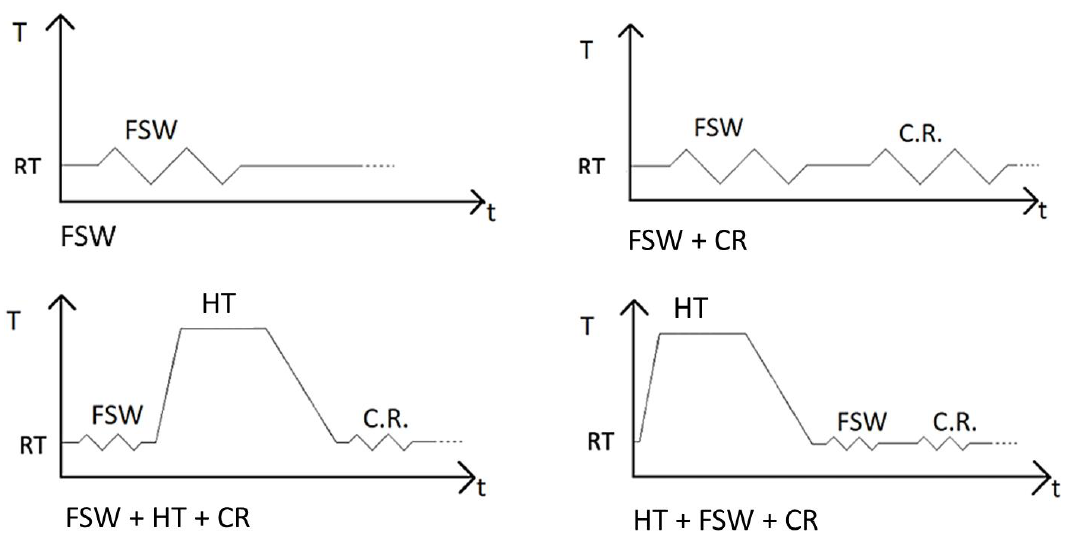
Figure 1. Schematics of the combinations of thermo-mechanical processes used in the present paper. Butt joints were obtained by FSW experiments carried out using the COMEC TM M50 (DRIVER M50 2T, Italy), a computerized numerical control machining center; the FSW process is schematized in Figure 2, which also shows the geometric characteristics of the pin tool (Table 2) and the welding parameters that have been set. The parameters used were selected on the basis of a previous study in which the weldability of the alloy AA5754-H114 was investigated.